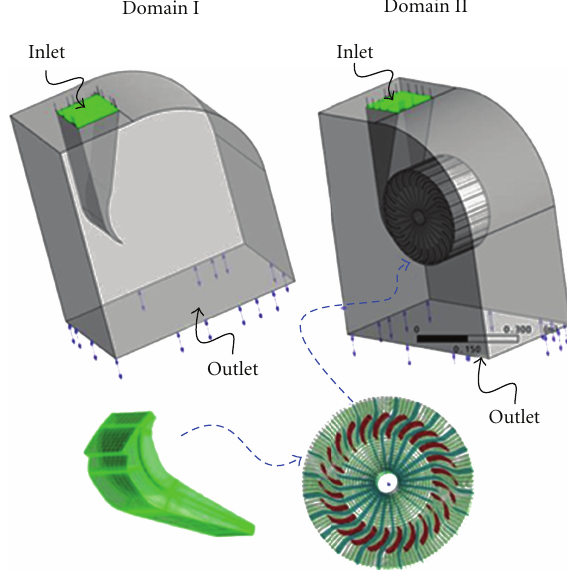
Figure 5: 3D views of the numerical domains I and II.